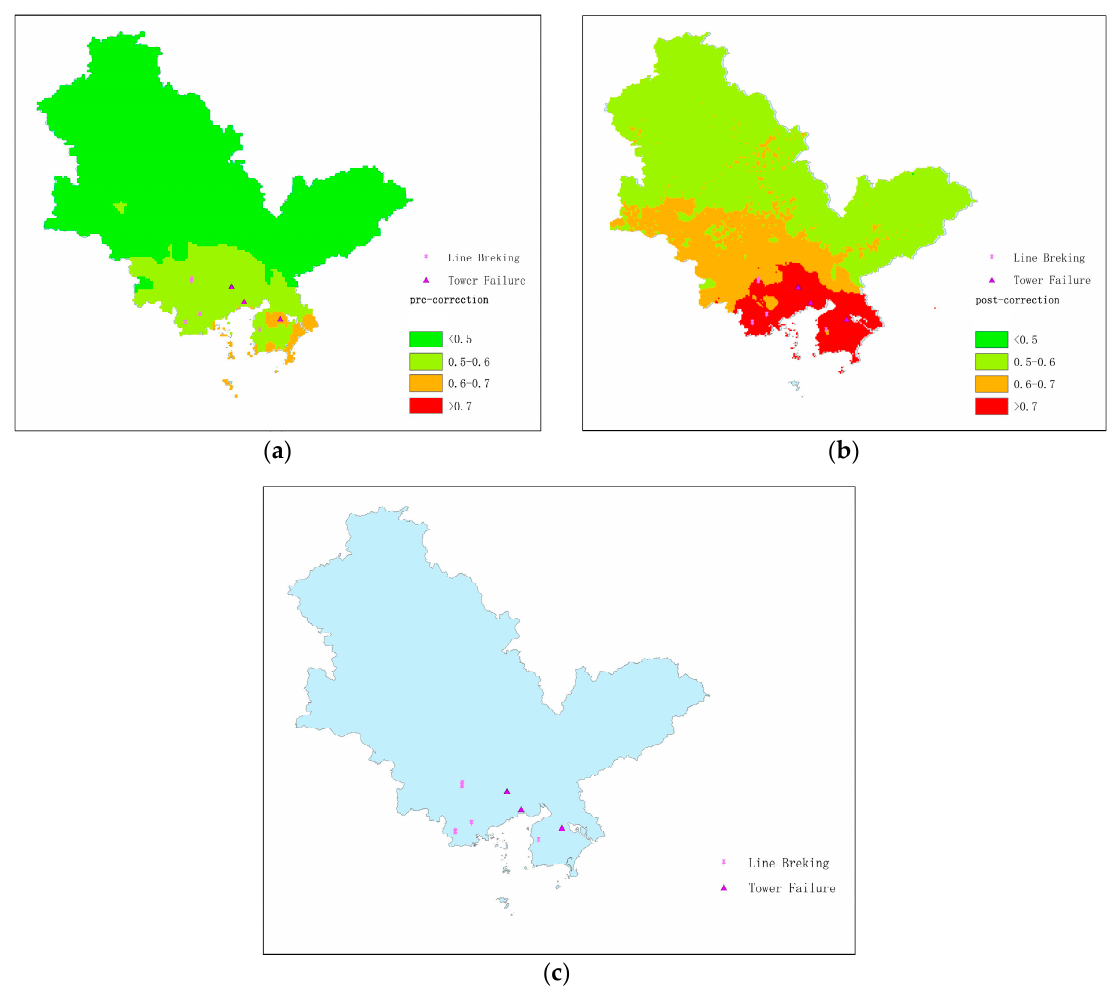
Figure 7. Predicted and actual damage distribution map. ( a ) Damage probability distribution map of pre-correction; ( b ) Damage probability distribution map of post-correction; ( c ) Actual damage distribution map.